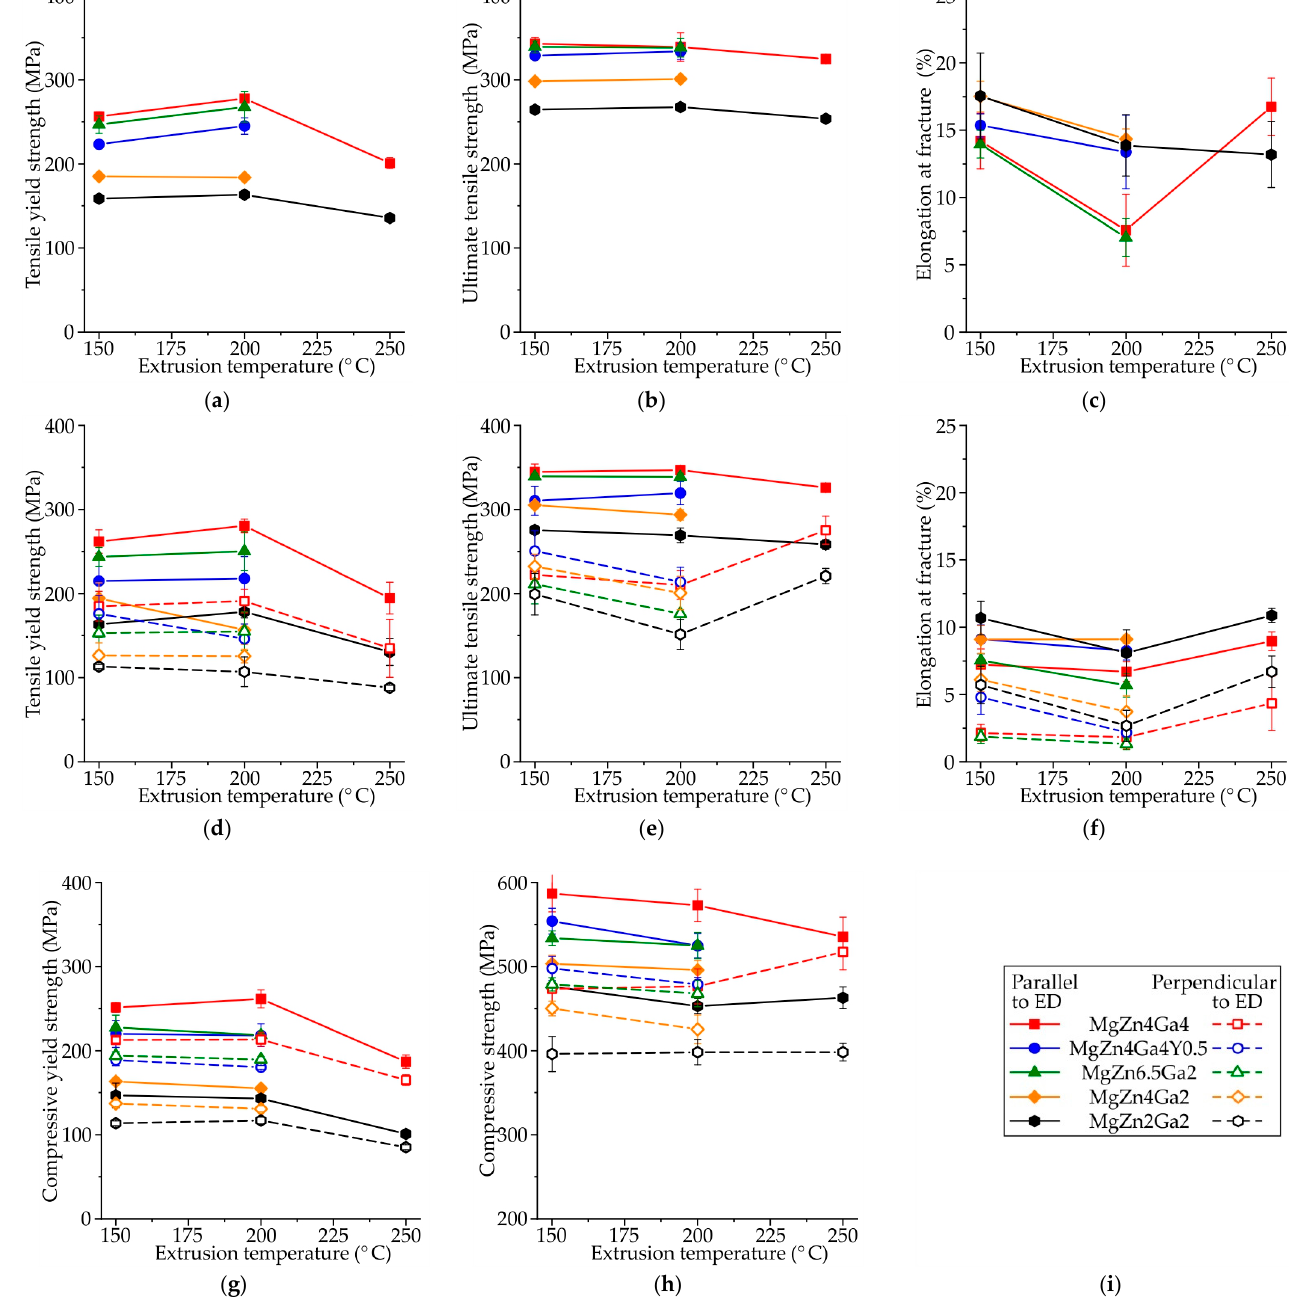
Figure 11. Mechanical properties as a function of the extrusion temperature of the Mg–Zn–Ga–(Y) alloys evaluated using ( a – c ) large standard cylindrical tensile-test specimens, ( d – f ) small flat-plate tensile-test specimens, or ( g , h ) small compression-test specimens cut along the directions parallel and perpendicular to the ED. ( a , d ) TYS; ( b , e ) UTS; ( c , f ) El; ( g ) CYS; and ( h ) CS; ( i ) legend. For high-alloyed alloys (MgZn4Ga4, MgZn4Ga4Y0.5, MgZn6.5Ga2), the tensile yield